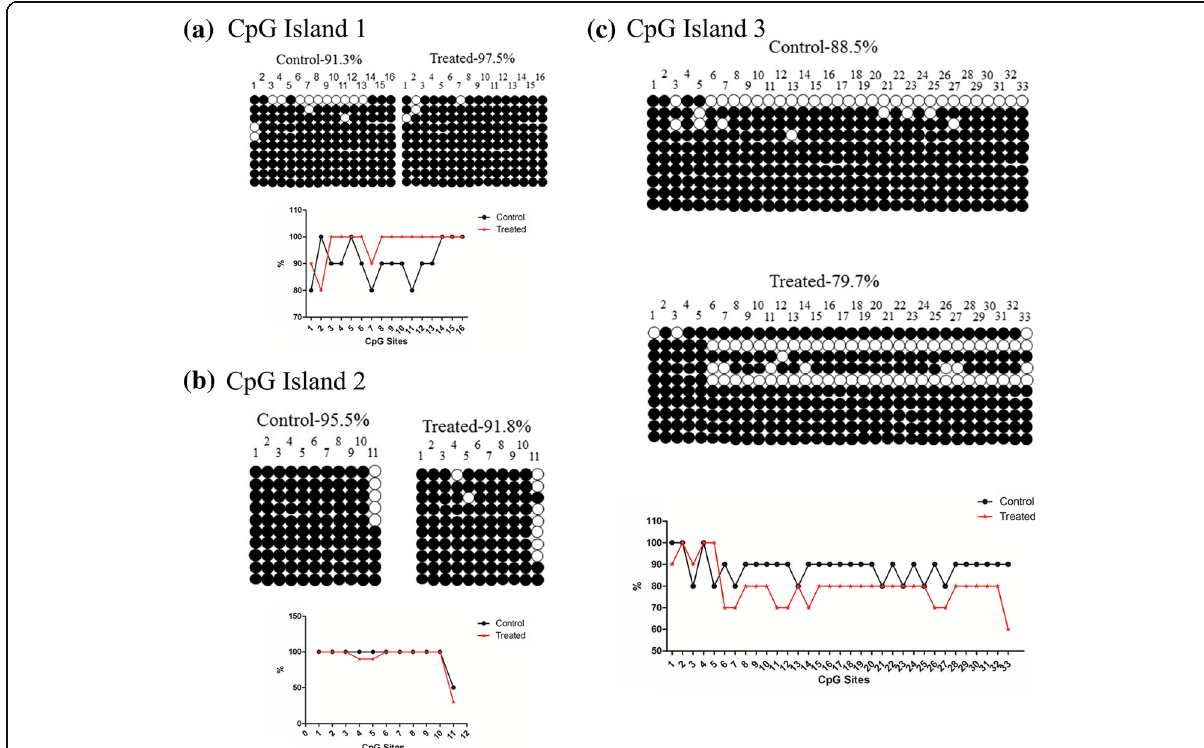
Fig. 5 The methylation of Dlk1/Dio3 DMR regions in testis. a The methylation of CpG island 1 in the control and treated tissues. b The methylation of CpG island 2 in the control and treated tissues. c The methylation of CpG island 3 in the control and treated